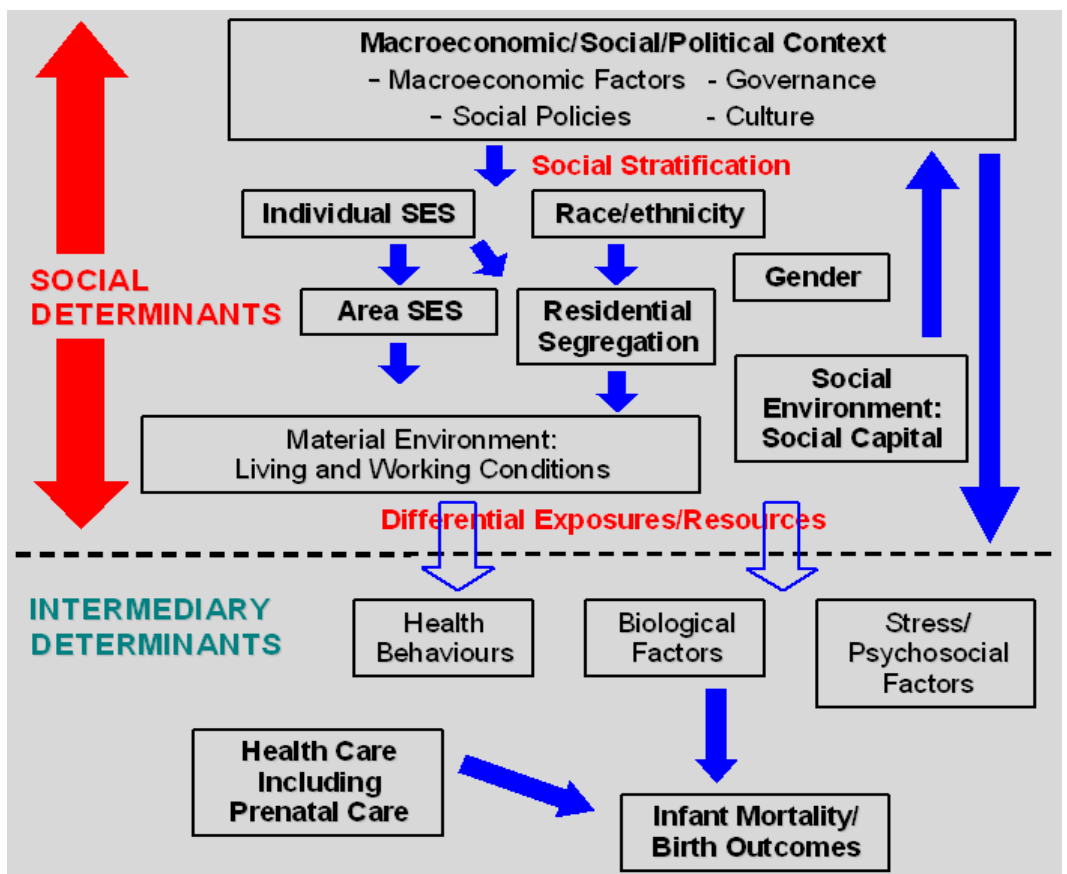
Figure 3. A Social Determinants of IM/Birth Outcomes Conceptual Framework. Adapted from Solar & Irwin